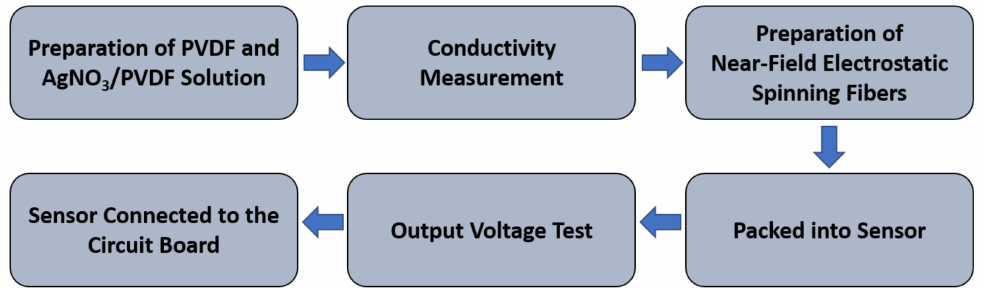
Figure 1. Overall experiment flowchart.